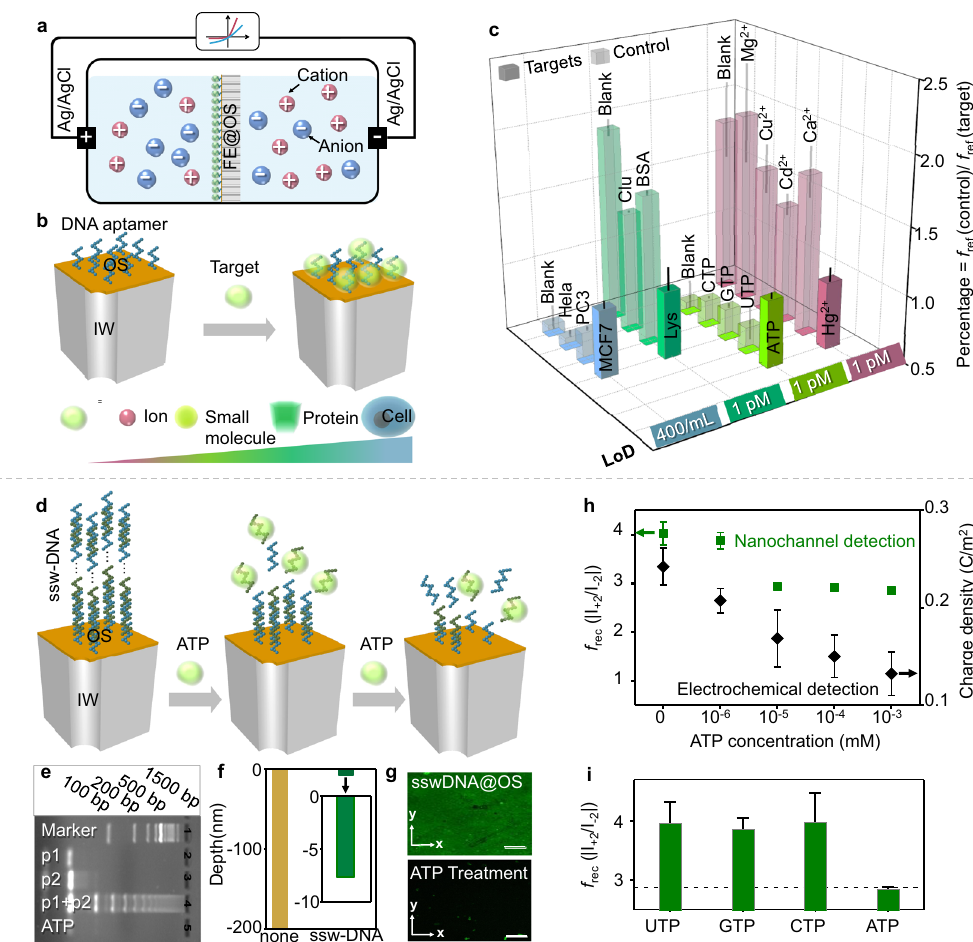
Fig. 5 Sensing performances of FE OS as probes. a A scheme showing the working mechanism of the sensor using FE OS as probes. b Capture process of multi-scale targets through designed single-stand DNA. c Sensitivity and selectivity of the DNA@OS (DNA is a designed sequence speci fi cally bonding with targets) for the recognition of ions (Hg 2 + ), small molecules (ATP), protein (Lysozyme) and cells (MCF7). The selective detection of multiscale targets using FE OS was realized based on the change of f rec signal output induced by the surface charge at outer surface. LoD is de fi ned as the limitation of detection for the targets. d Formation of “ supersandwich ” DNA structure (ssw-DNA) with long concatamers through the successive hybridization of alternating DNA unit. And gradual disassembly of ssw-DNA based on interaction between ATP and the repeat DNA units through increasing ATP concentration. e Agarose gel electrophoresis characterizing of the ssw-DNA: 1) DNA marker; 2) p1; 3) p2 (ATP ampter); 4) p1 + p2; 5) target + p1 + p2. f Depth distribution of the “ supersandwich ” DNA in nanochannel-system using ToF-SIMS. g Laser scanning confocal microscopy of the OS after the assembly (top) and the disassembly of ssw-DNA (bottom). The scale bar is 20 μ m. h The LoD of ATP using ssw-DNA as probe based on nanochannel method and electrochemical method (Fig. S30). i Speci fi city of ssw-DNA@OS for ATP, in contrast with other NTPs. For the sensing performances part, fi ve sensors using FE@OS were established to obtain each error bar of sensitivity and speci fi LbL self-assembly of charged polyelectrolyte. For LbL self-assembly of PAA and PEI on the outer surface of AAO/Au nanochannels, the process was described as